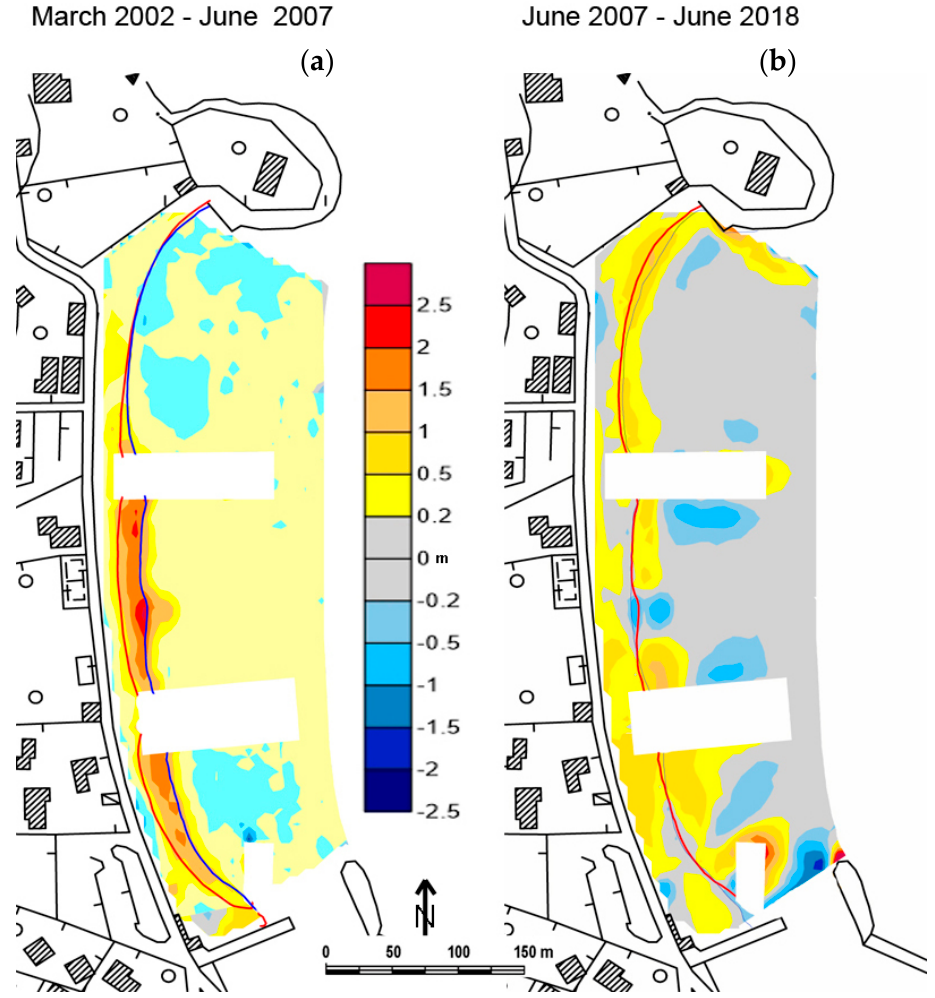
Figure 8. Beach vertical changes (m) at Cavo considering the 2002 − 2007 ( a ) and 2007–2018 ( b ) sur- veys.